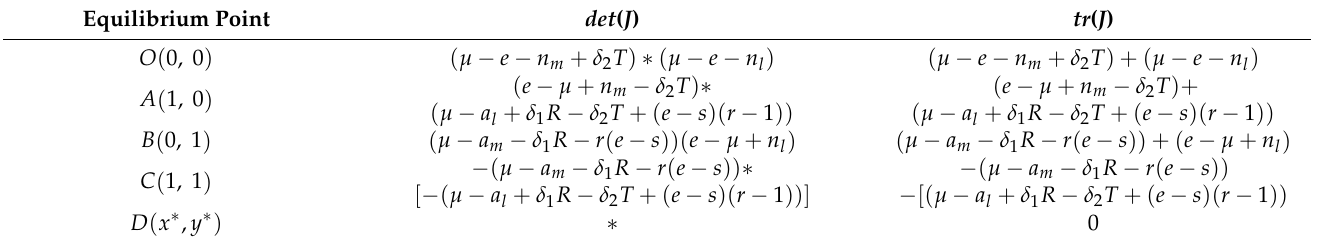
Table 3. Determinants and traces of equilibrium